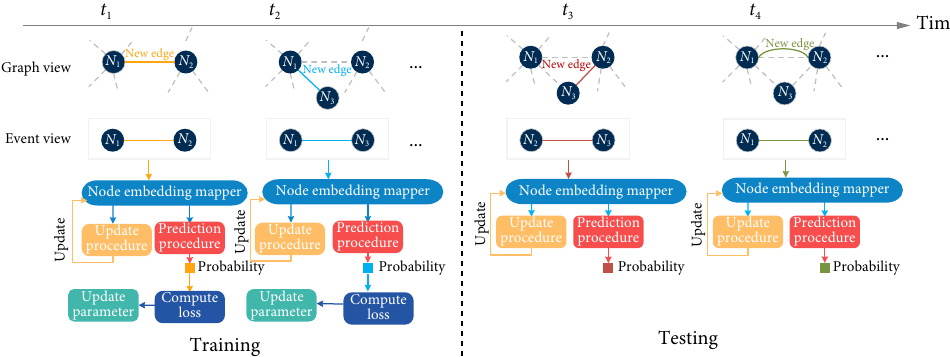
Fig. 4 Training and testing processes of ECHN. ECHN processes each event in chronological order. The update procedure is performed to update node embedding vectors in the training and prediction processes. The prediction procedure is utilized to compute loss as well as update the parameters in the training process whereas it is used to compute the probability of the event in the testing